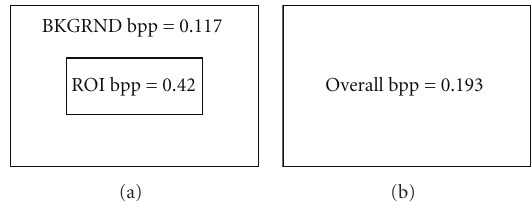
Figure 1: Illustration of bit per pixel density at 500kbps and 360 × 240 pixels with (a) ROI compression: ROI bpp = 0.42; ROI bit rate = 0.42 × 360 × 240 × 0.25 × 30 = 270 kbps; BKGRND bit rate = 500 − 270 = 230 kbps; BKGRND bpp = 230000/(30 × 360 × 240 × 0.75) = 0.117 and (b) uniform compression: overall bpp = 500000/(30 × 360 × 240) = 0.193.